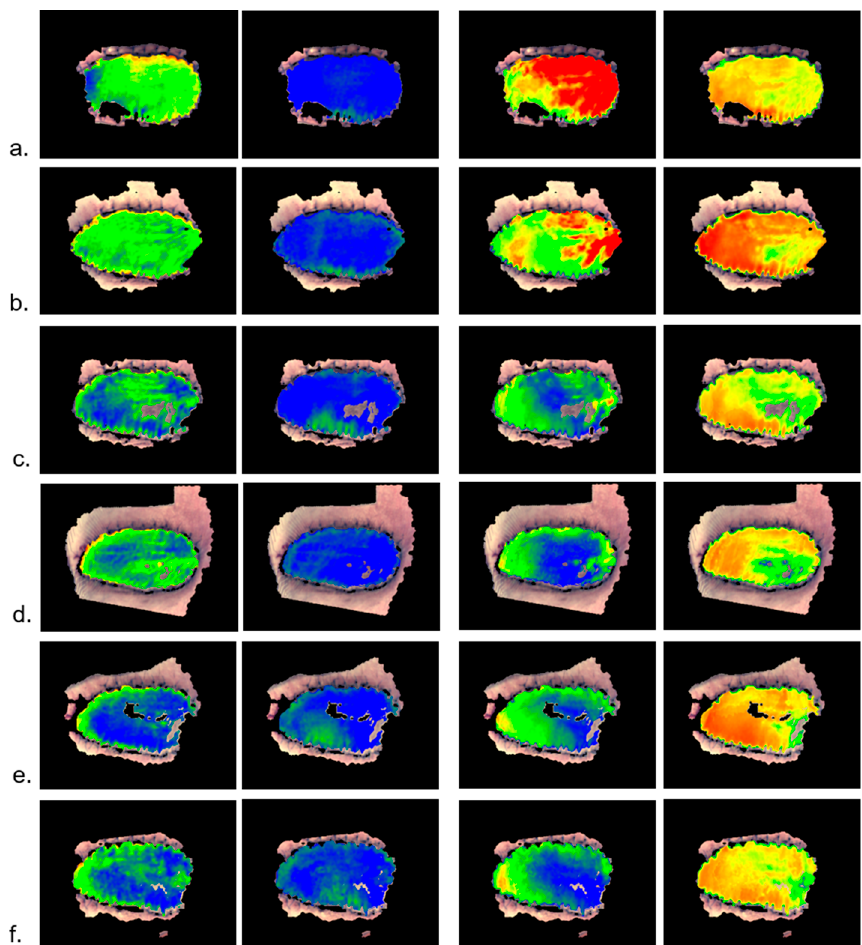
Figure 5. Same transplant measured at the following days ( a : day 3, b : day 5, c : day 7, d : day 9, e : day